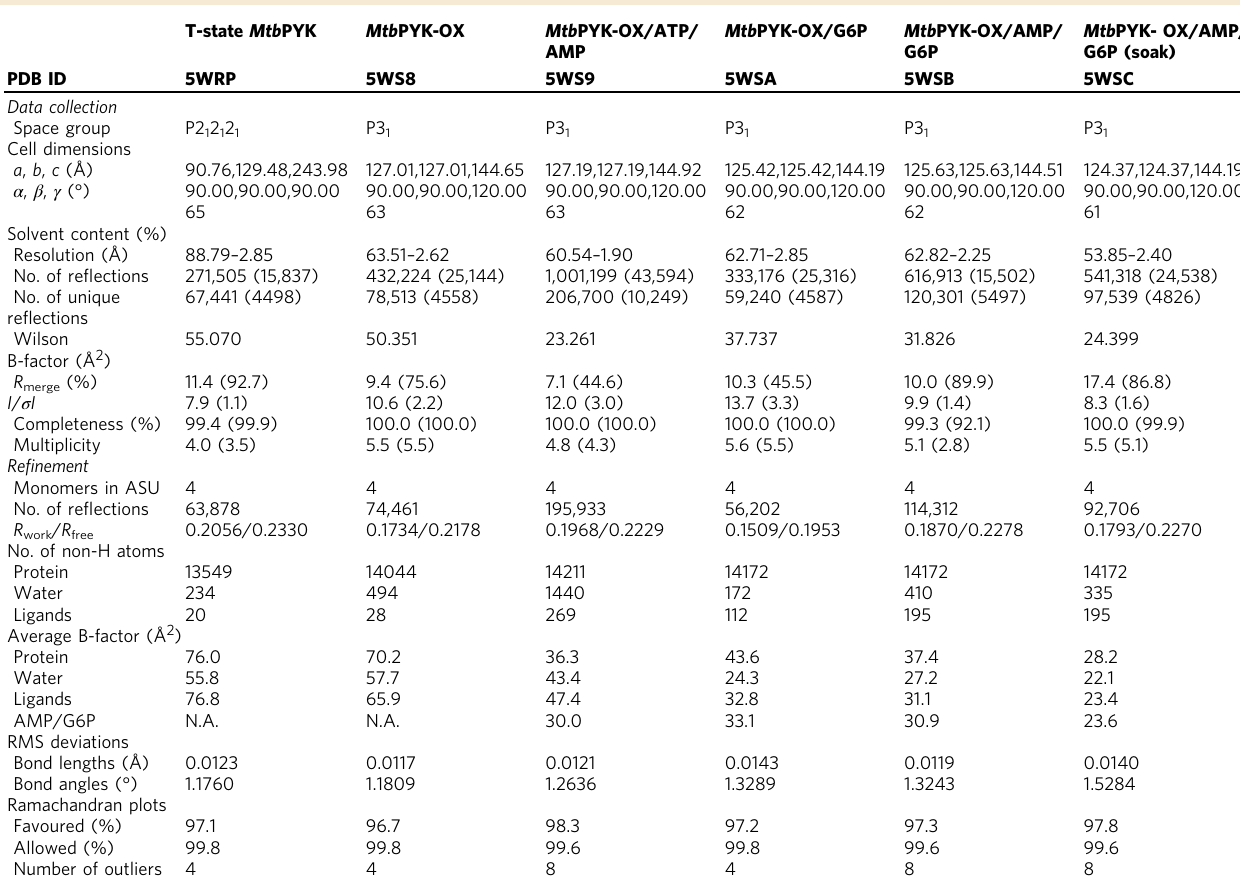
Table 2 Data collection and re fi nement statistics